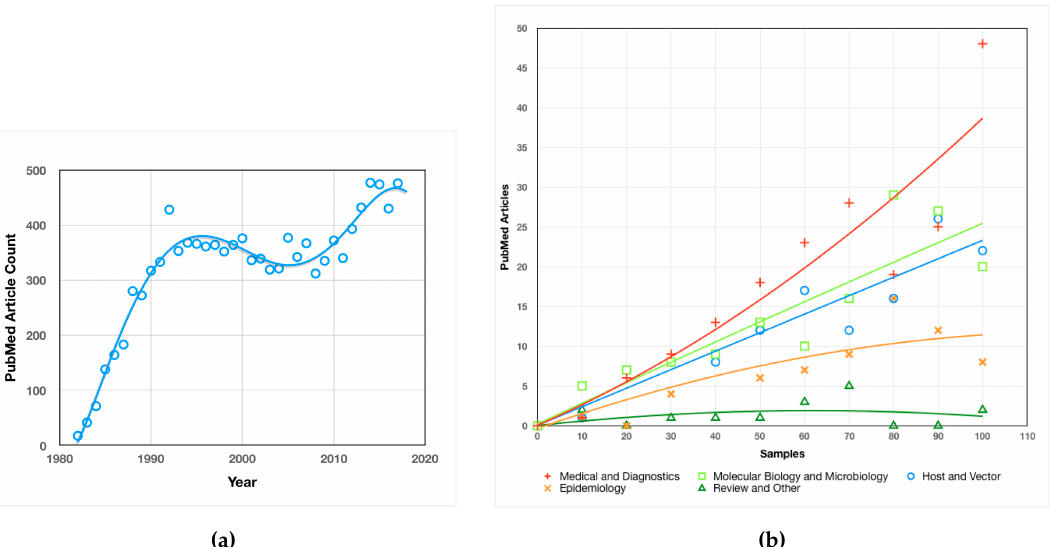
Figure 4. Analysis of Borrelia Research: (a) Borrelia PubMed Article Count by Year—Number of PubMed articles found for the query “ Borrelia ” plotted by year of publication. Curve fitting was achieved by the application of a third order polynomial trendline in the Mac Numbers OS / X application; (b) Borrelia Research Emphasis—Rarefaction curves indicating the richness of diversity for broad categories of Borrelia research.